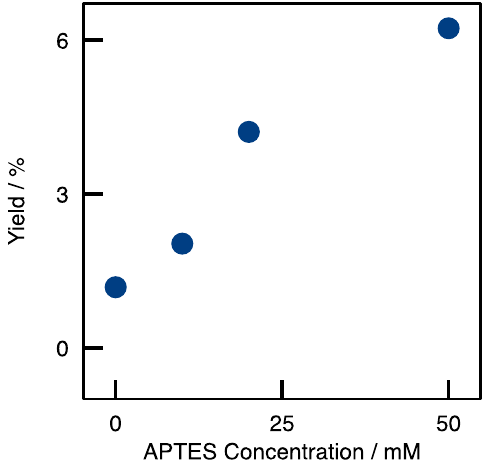
Figure 8. Effect of APTES concentration in the grafting solution on biocatalysts efficiency. Increasing APTES concentration allows enhancing the yield. Yield values are the averaged yield measured after 180 min time on stream (where the yield appeared to stabilize).